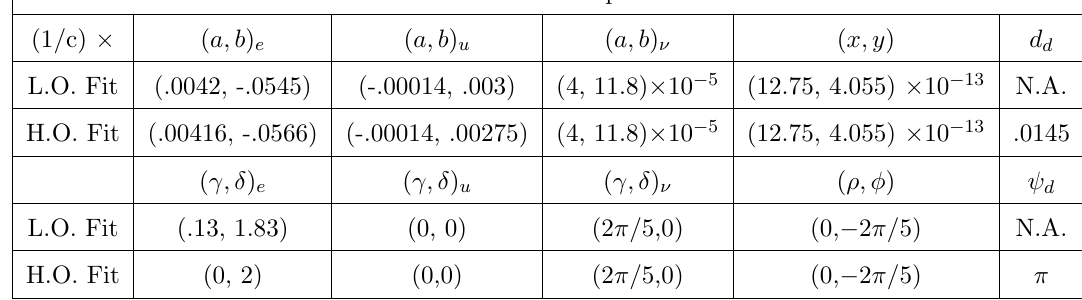
Table 3 . Free parameters used for (cid:12)tting the fermionic mass and mixing spectrum. As discussed in the text, only nine parameters are relevant to constraining the low-energy (cid:13)avour phenomenology at lowest order in the operator product expansion. The mass and phase parameters of the down quarks are implied by the corresponding values for the charged leptons. The parameters d d and d are only relevant to (cid:12)ts including the higher order operator / (cid:6) S in eq. (2.8), which sources an independent entry analogous to eq. (5.2) labeled d 0 =c (cid:17) de i . The subscript d indicates that this contribution is only turned on for the down quarks (and hence also the charged leptons). Note